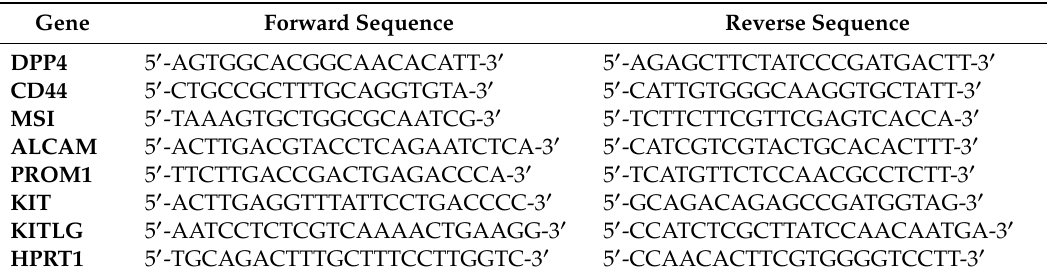
Table 1. List of primer sequences used in